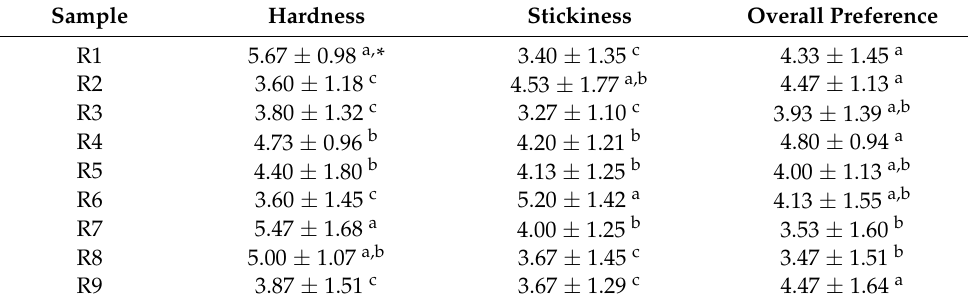
Table 4. Sensory evaluation of cooked rice